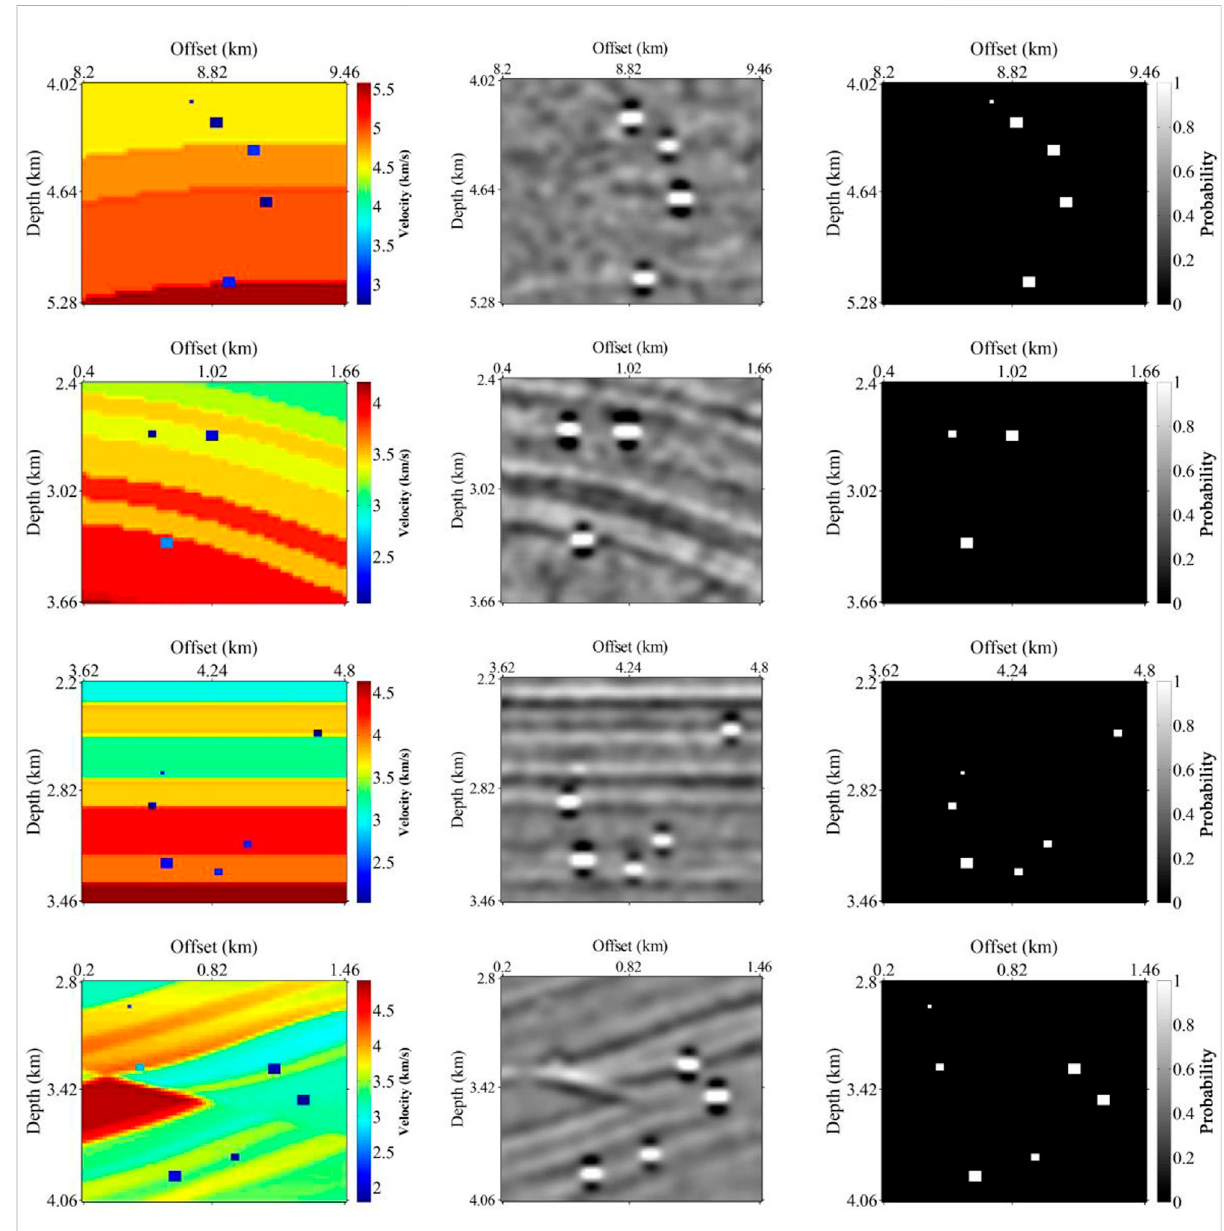
FIGURE 6 Four representative samples of the training data set. The fi rst column is the velocity models, the second column represents the corresponding seismic images as inputs, and the third column shows the karst cave probability distribution maps as the